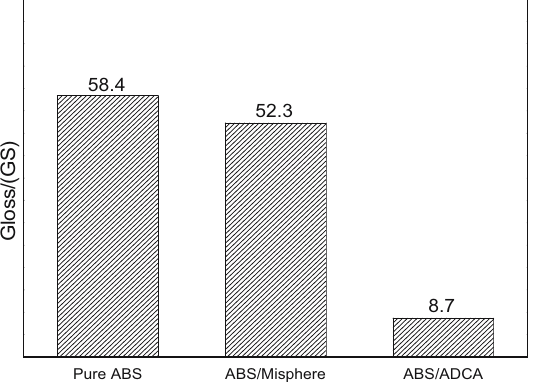
Figure 8: E ff ect of blowing agent on the gloss of foamed ABS material.